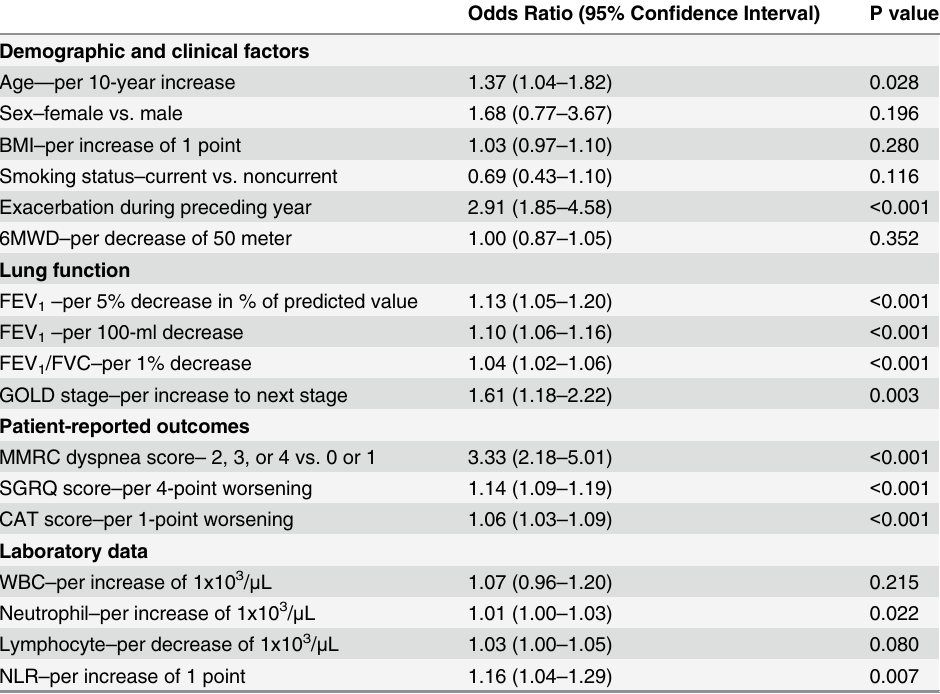
Table 3. Univariate Association with the Occurrence of Exacerbation during the First Year of Follow- up. Odds Ratio (95% Con fi dence Interval) P value